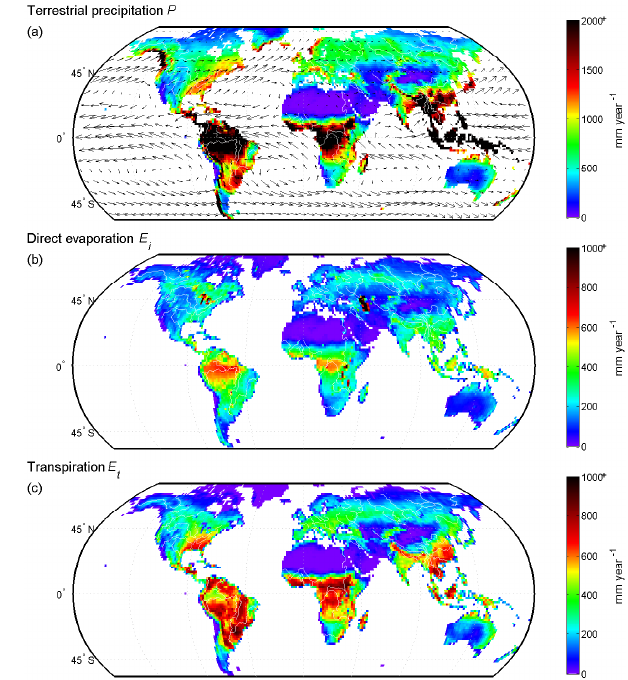
Figure A1. Average continental precipitation and evaporative fluxes (1999–2008). (a) Precipitation; (b) direct evaporative flux, dominated by interception (Eq. 2); and (c) delayed evaporative flux, i.e. transpiration (Eq. 3). The arrows in (a) indicate the vertically integrated moisture